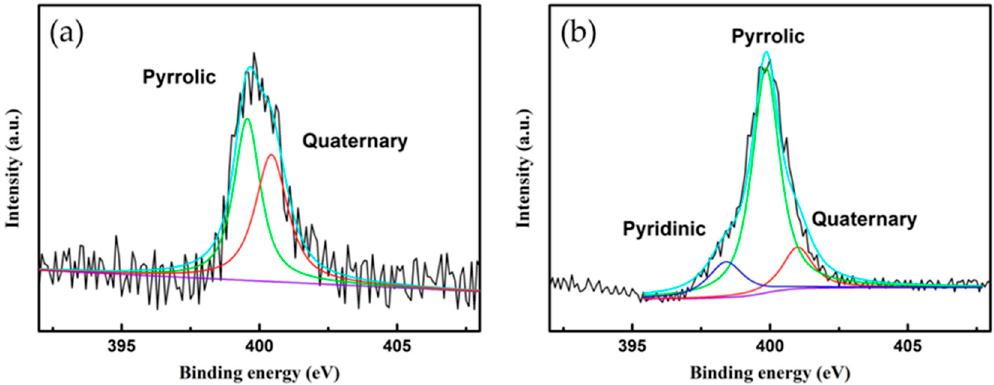
Figure 5. XPS spectra of ( a ) untreated and ( b ) N-doped NTE-graphite. The deconvolution of the peak results in three subpeaks. Red line: Quaternary N, green line: Pyrrolic N, violet line: Pyridinic N, and greenish-blue line: the sum of the deconvoluted spectrum.